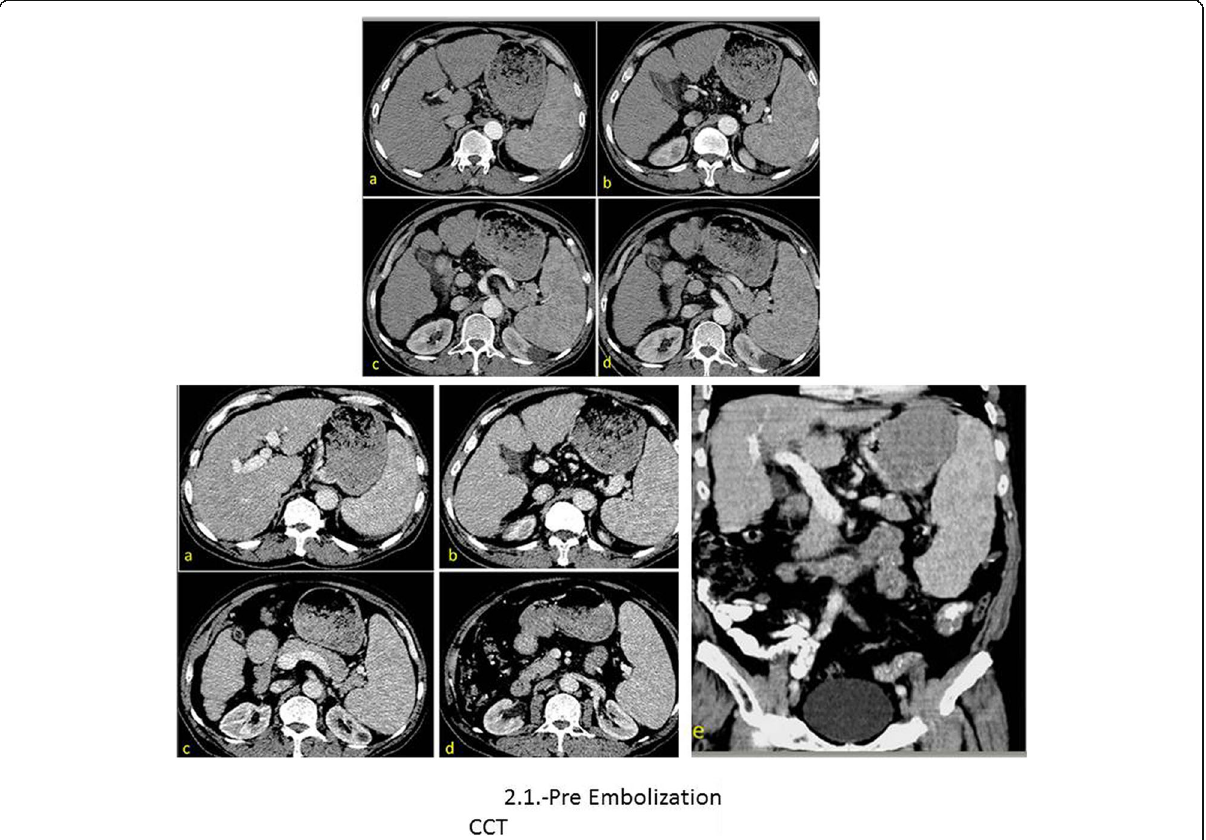
Fig. 2 Male patient, 55 years old, with HCV, complaining left hypochondrial pain and bleeding tendency. Pre-embolization. Contrast abdominal CT examination at the artery. a – d Axial cuts at the arterial phase showing cirrhotic liver with splenomegaly. The splenic artery seen originates from the celiac trunk. CT at the portovenous phase. a – d Axial images. e Coronal